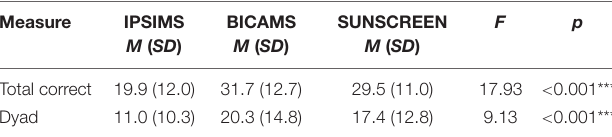
TABLE 2 | Between-study differences in 2 (cid:48)(cid:48) PASAT performance measures for the MS group.